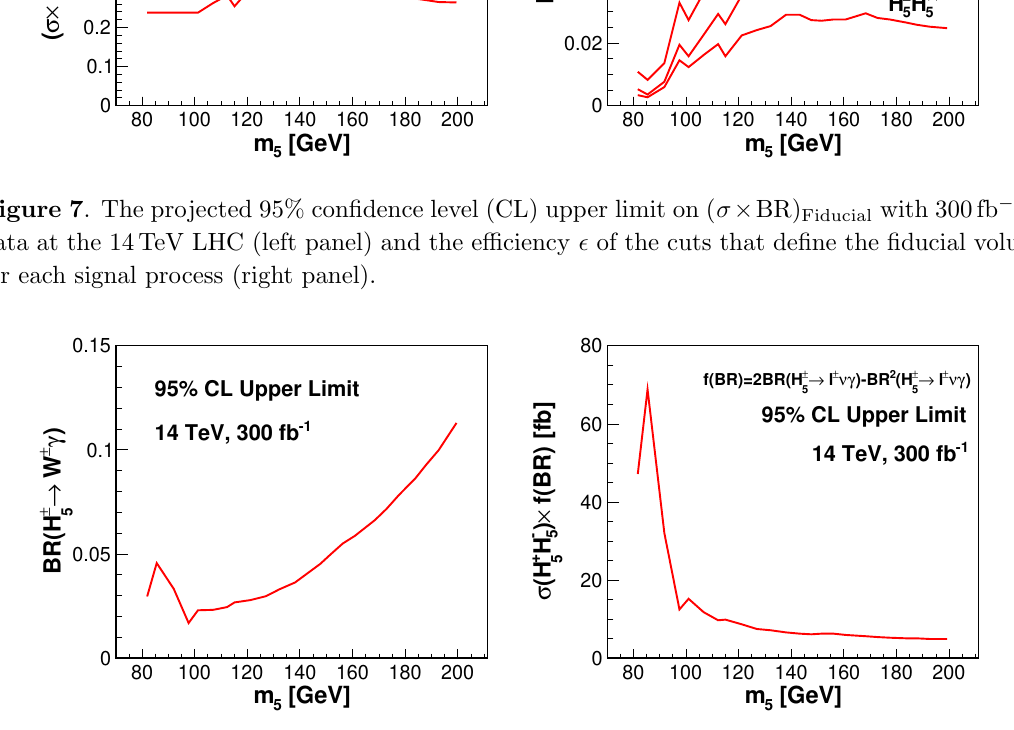
W (cid:6) (cid:13) ) in the GM model from 5 ! H + H (cid:0) ) (2BR( H (cid:6) 5 5 5 ! ! (cid:2) H + H (cid:0) is the only signal process. Both plots 5 5 !